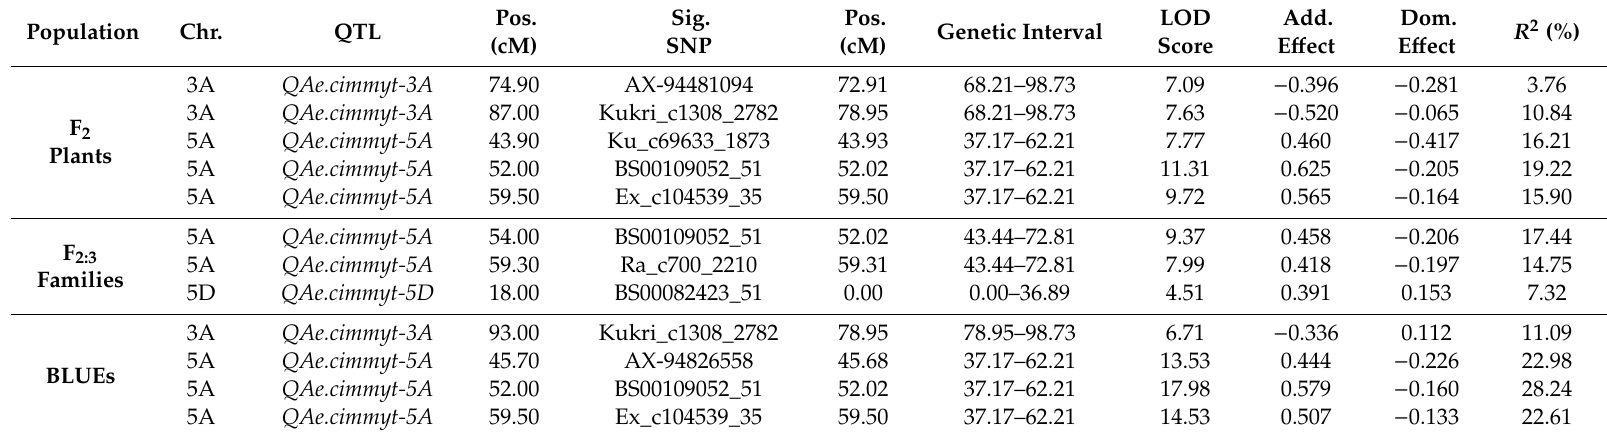
Table 2. Quantitative trait loci (QTL) for anther extrusion in F 2 and F 2:3 progenies, and their best linear unbiased estimations